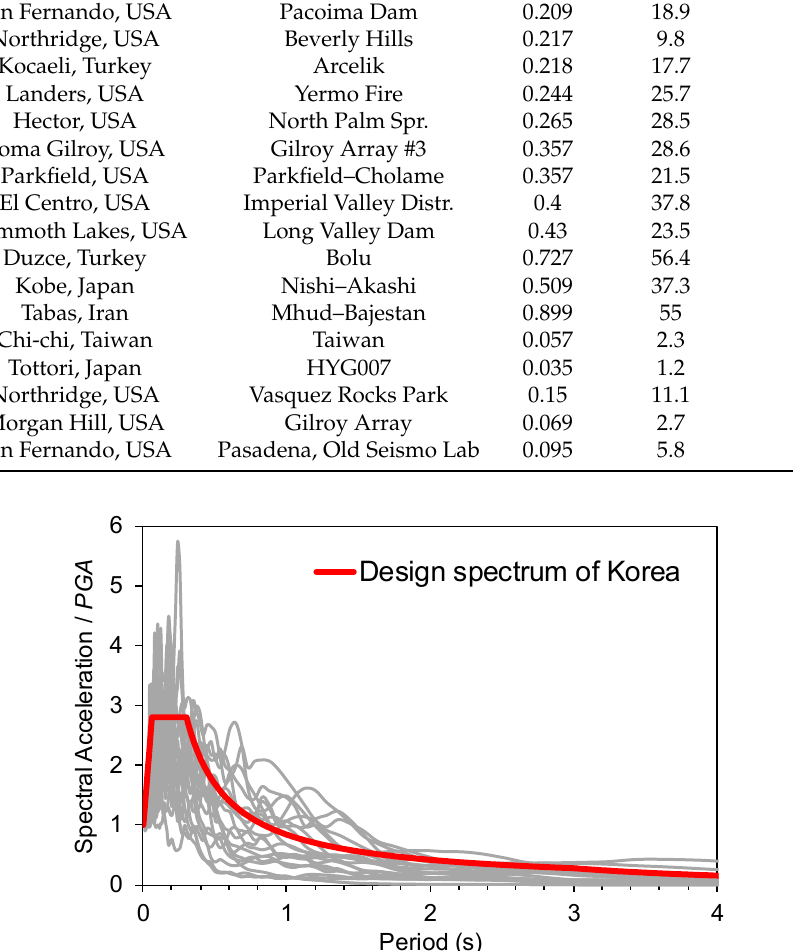
Table 3. Details of input ground motion selected to perform nonlinear dynamic analyses.